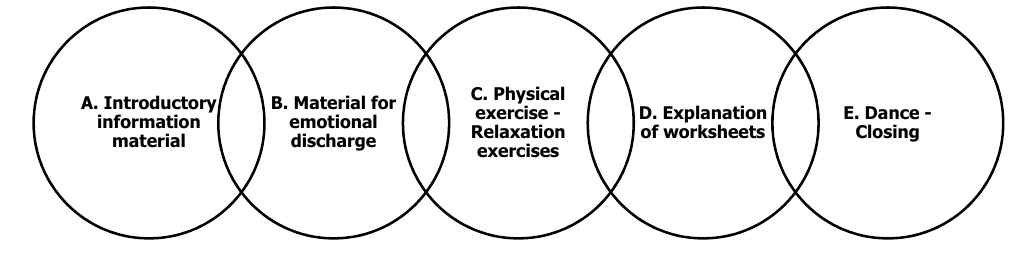
Figure 1. Structure of each supporting information package.